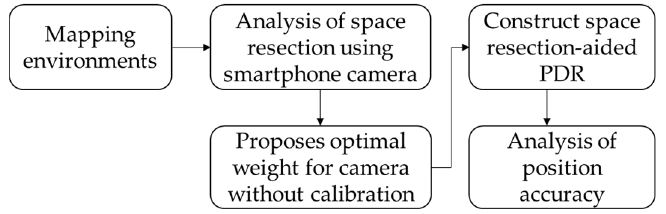
Figure 1. The flowchart of this research.